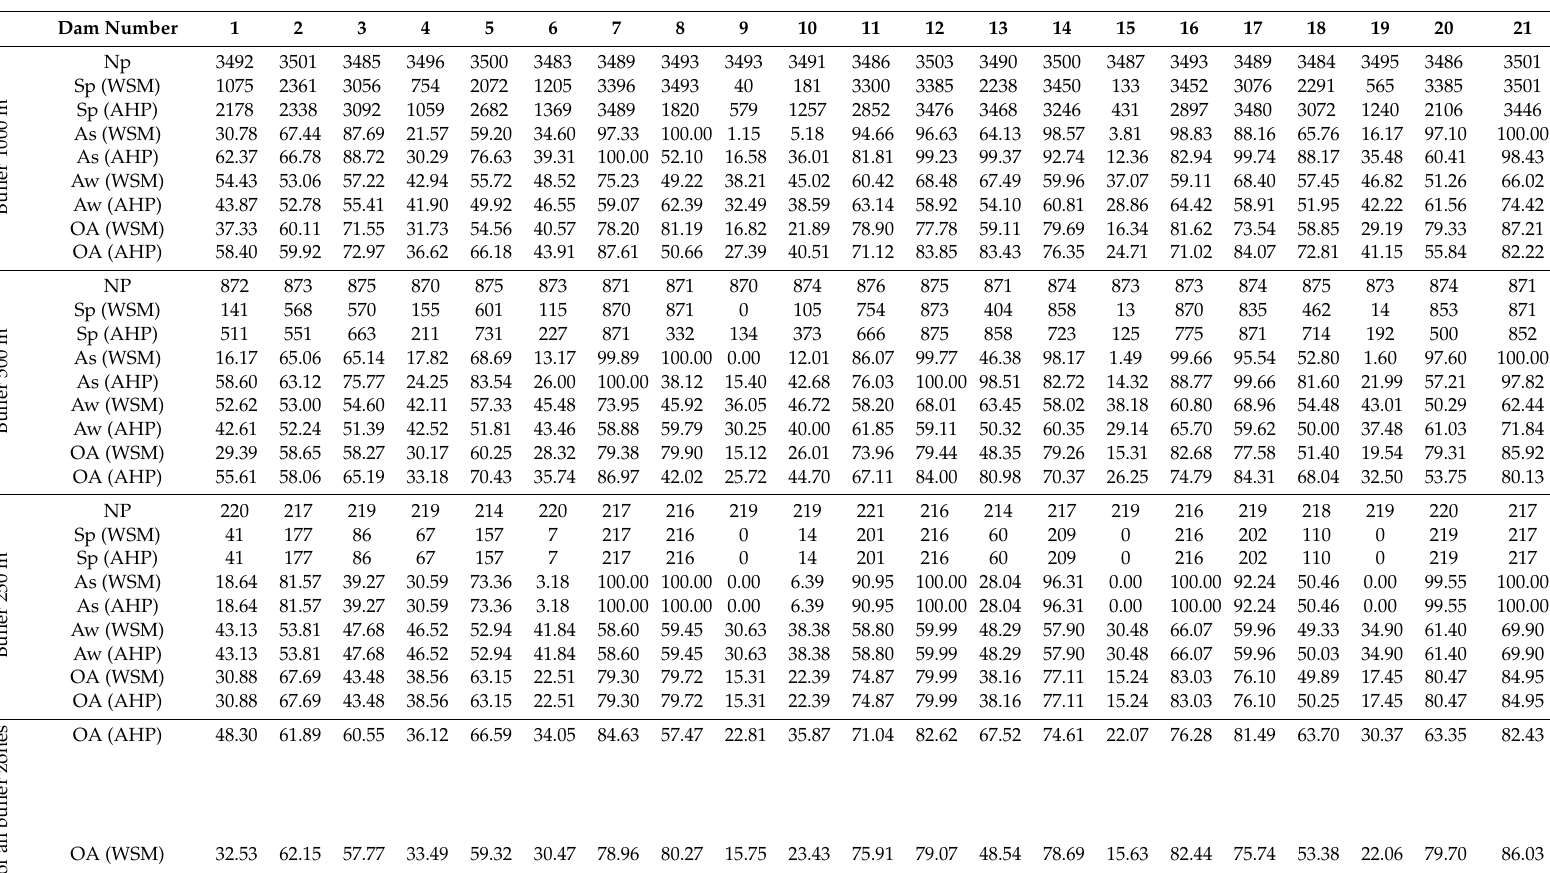
Table A4. The overall accuracy of dam site selection using WSM and AHP